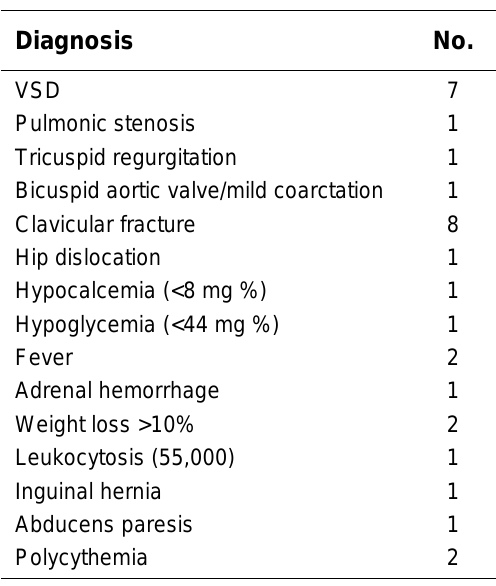
Diagnoses Other than